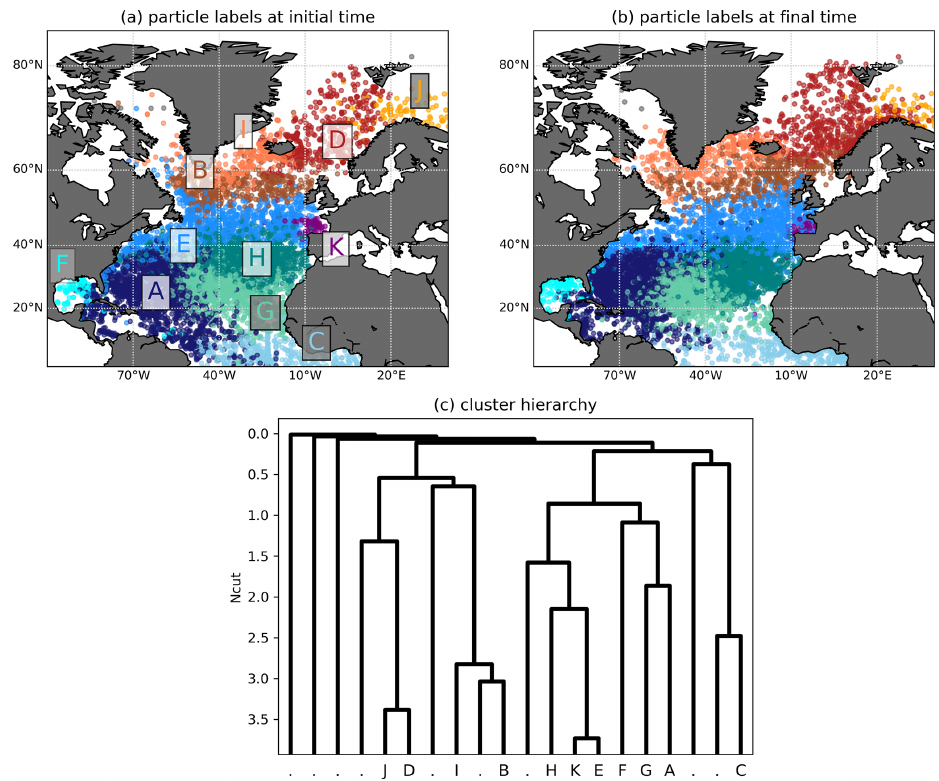
Figure 6. (a) Clustering of Q for the drifter data set with (cid:49)x = (cid:49)y = 1 ◦ . Clusters corresponding to one or two particles are coloured in grey. Oceanographic regions of the individual clusters (if existing): D: Norwegian Sea, E: Western Boundary Current region, F: Caribbean Sea, I: Irminger Current, J: Barents Sea, K: Bay of Biscay. Names of groups of clusters: Subtropical Gyre (A, F, G, E, H, K), Subpolar Gyre (B, I), Nordic Seas (D, J). (b) Clustering result plotted at final time. (c) Hierarchy of the different splits. For each split, the (inverted) y axis shows the respective NCut after the split. Clusters corresponding to one or two particles are labelled by “.”. The initial conditions are randomly shuffled prior to plotting such that no colour dominates another one at the region